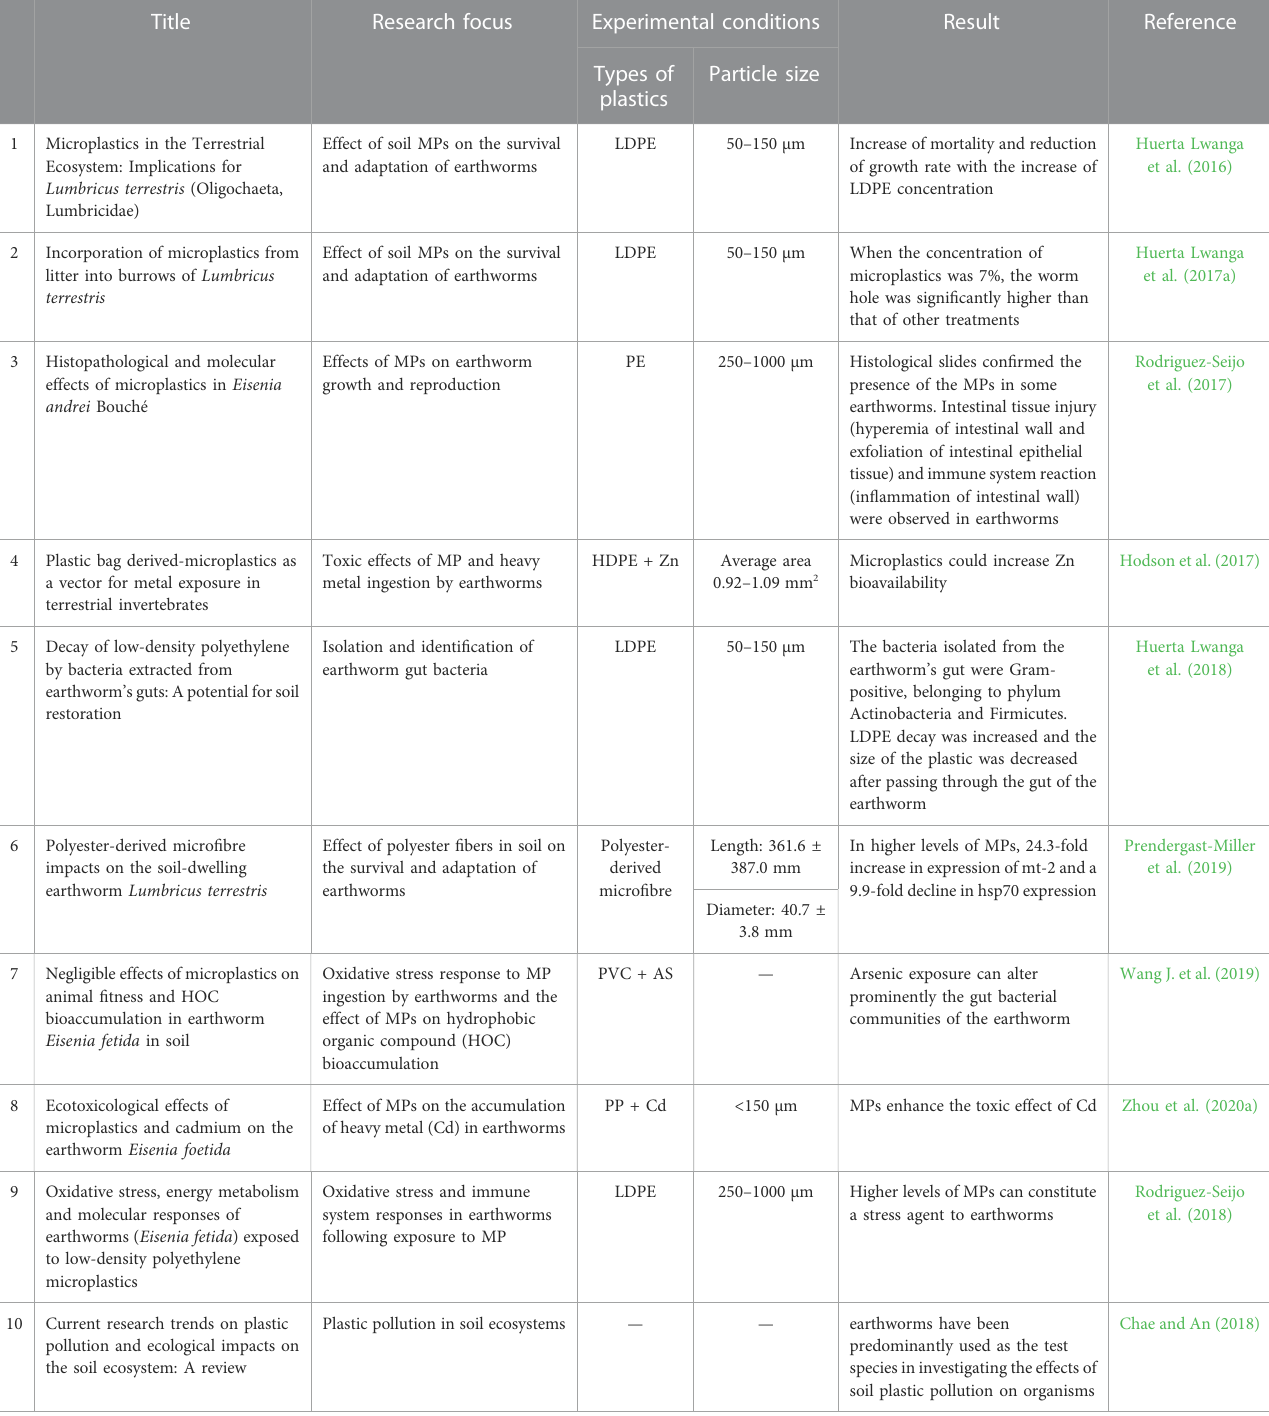
TABLE 1 Highly cited literature on the interactions between microplastics (MPs) and earthworms (published up to December